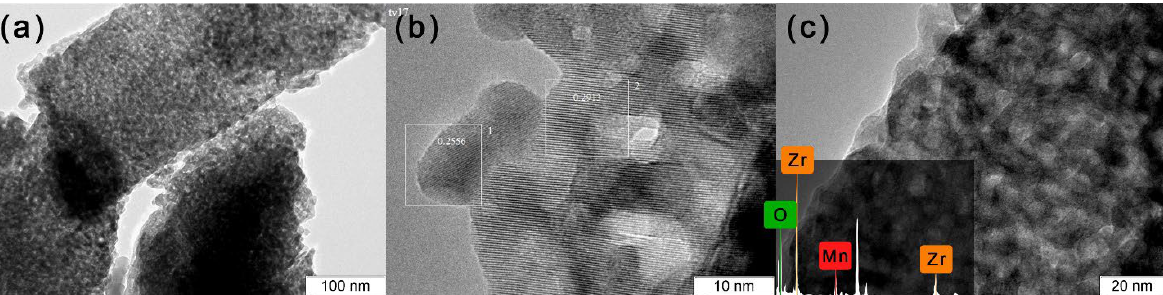
Figure 4. TEM images ( a , b ); with EDX spectra ( c ); the COP-650